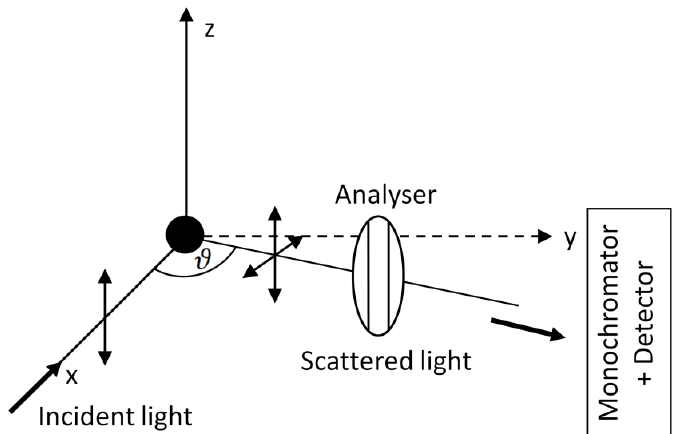
Figure 1. Scheme of a general Raman scattering geometry. The excitation beam travels along the 𝑥 direction with polarization in the 𝑧 direction and the detector collects light scattered in the 𝑥𝑦 plane at an angle 𝜗 with respect to the 𝑥 axis. An analyser may be inserted between the sample and the monochromator to allow only one specific Raman polarization enter the detector.